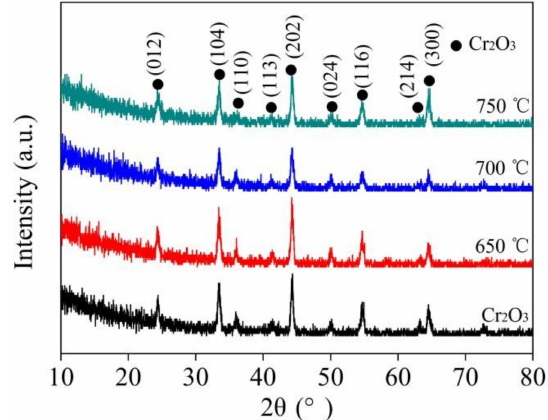
Figure 2. XRD patterns of the pre-sealed and post-sealed Cr 2 O 3 coatings heat-treated at different